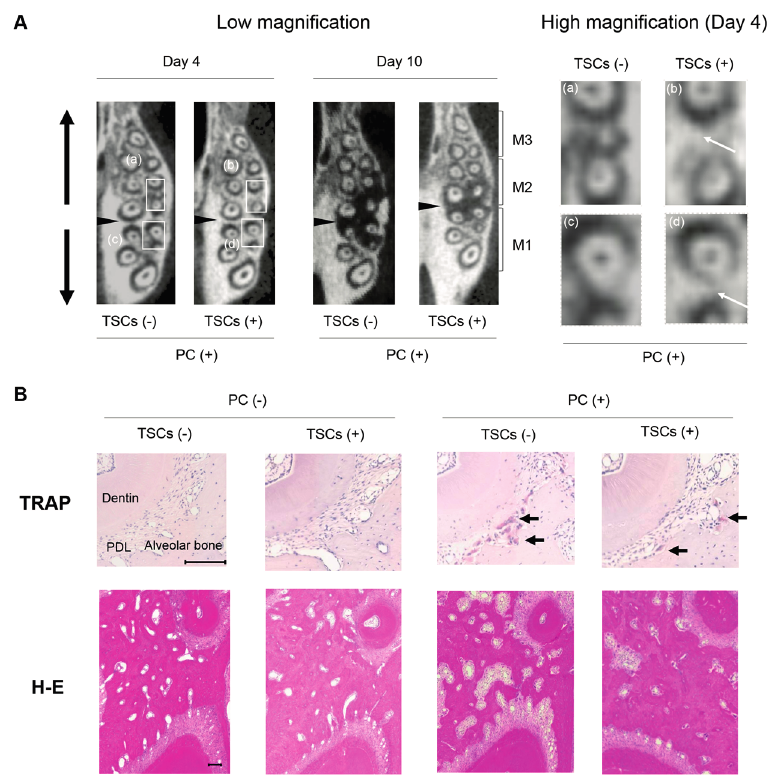
Scale Bar: 200 µm. Black arrows: representative bone marrow cavities used for the quantification; ( D ) Quantitative data for the number of TRAP-positive cells in each